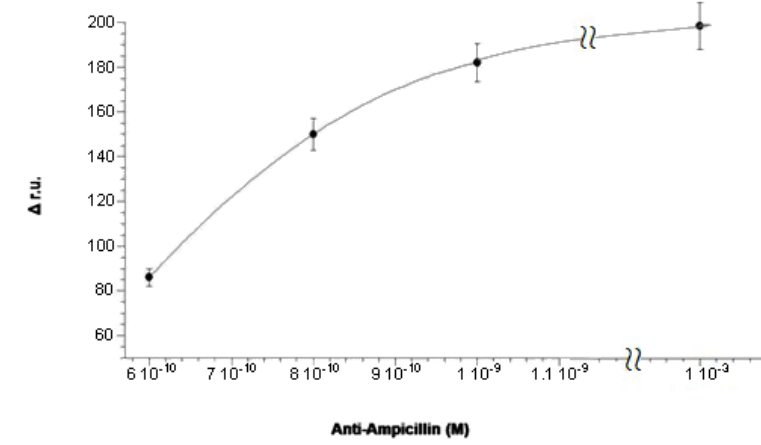
Figure 7. “Saturation curve” with anti-ampicillin, obtained by flowing antibody solutions: 6 × 10 − 10 M, 8 × 10 − 10 M, 1 × 10 − 9 M, 1 × 10 − 3 M).